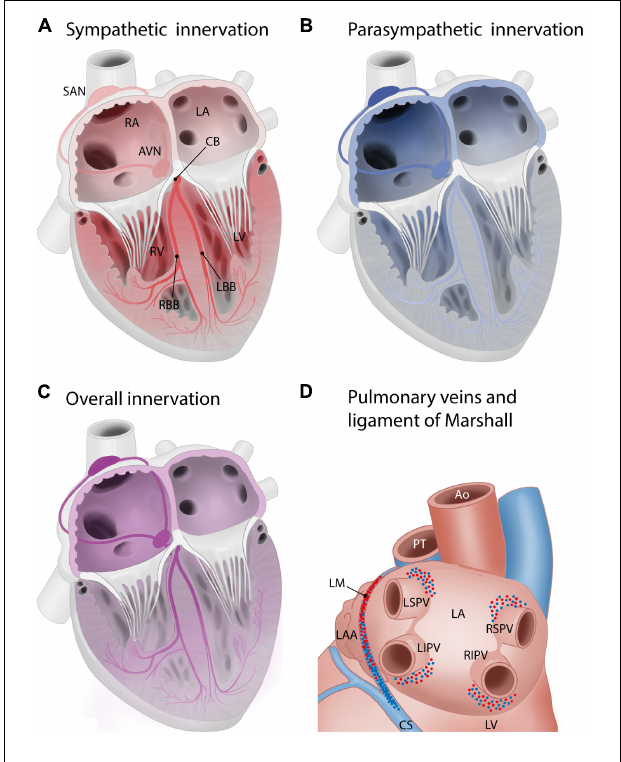
FIGURE 4 | Innervation of the cardiac muscle, including the cardiac conduction system. Red: sympathetic innervation, blue: parasympathetic innervation. (A,B) Schematic overview of sympathetic (A) and parasympathetic (B) innervation of the cardiac compartments and cardiac conduction system. Innervation gradient ranging from the most to least dense innervation: sinoatrial node > atrioventricular node > penetrating bundles > bundle branches. The conduction system is more densely innervated than surrounding myocardium. Sinoatrial node and atrioventricular node: predominantly parasympathetic innervation, penetrating bundle and the bundle branches: predominantly sympathetic (Crick et al., 1994; Chow et al., 2001). (C) Global innervation densities in cardiac areas. Innervation density in the atria > innervation density in the ventricles. Gradient in innervation density (higher to lower) from base to the apex. Atria: most nerve endings parasympathetic. Ventricles: most nerve endings sympathetic. Sympathetic innervation density right atrium > left atrium. Right atrium and right ventricle: higher density of parasympathetic innervation than left atrium and left ventricle (Kawano et al., 2003). (D) Innervation of the pulmonary veins and ligament of Marshall, posterior view of the left atrium. Sympathetic and parasympathetic innervation density: highest above superior pulmonary veins and below inferior pulmonary veins (Tan et al., 2006). The ligament of Marshall is densely sympathetically and parasympathetically innervated (Han et al., 2010; Rodríguez-Mañero et al., 2016). From superior to inferior, it shifts from predominantly sympathetic to predominantly parasympathetic. AVN, atrioventricular node; AVB, atrioventricular/His bundle; CB, common bundle; LA, left atrium; LBB, left bundle branch; LIPV, left inferior pulmonary vein; LSPV, left superior pulmonary vein; LV, left ventricle; SAN, sinoatrial node; RA, right atrium; RBB, right bundle branch; RIPV, right inferior pulmonary vein; RSPV, right superior pulmonary vein; RV, right ventricle.